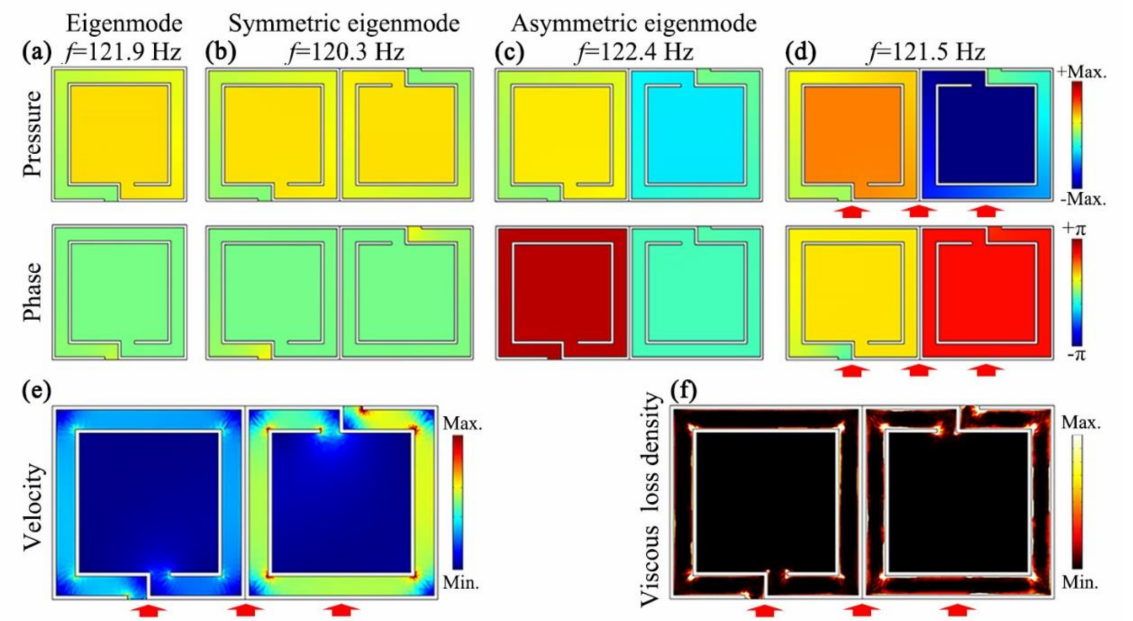
Figure 3. ( a ) Simulated pressure and phase eigenmodes of a single Helmholtz resonator at 121.9 Hz, and those of the unit, corresponding to the following: ( b ) symmetric eigenmode at 120.3 Hz; ( c ) asymmetric eigenmode at 122.4 Hz; ( d ) simulated pressure and phase distributions in the unit created by the normal incidence of sound (red solid arrows) at 121.5 Hz. Simulated distributions of ( e ) velocity of air flow and ( f ) viscous energy-loss density in the unit created by the normal incidence of sound (red solid arrows) at 121.5